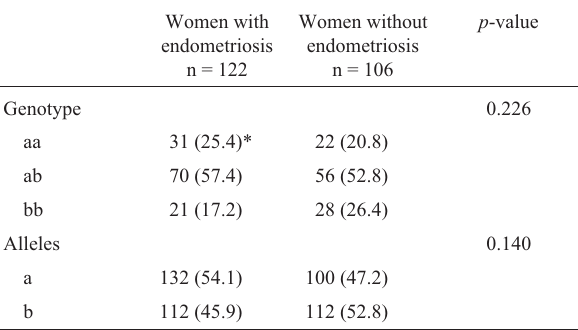
Table 1 - Allele and genotype frequencies of the IGF2 gene Apa I polymorphism in women with or without